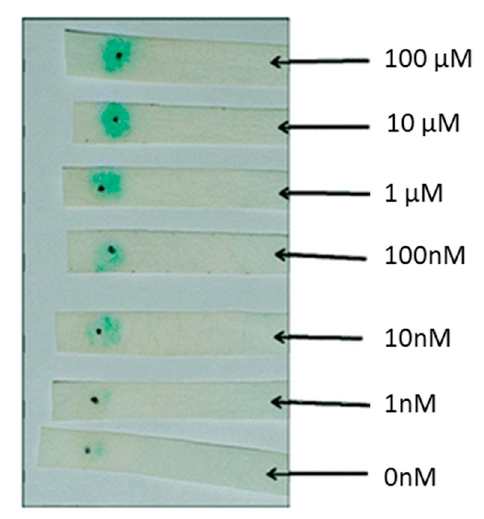
Figure4. C12HSL E.coli DH5 α -T1paperbiosensor.Reprintedwithpermissionfrom[93]. Copyright2010 Figure 4. C12HSL E. coli DH5 α -T1 paper biosensor. Reprinted with permission from [93]. Copyright American Chemical 2010 American Chemical Society.